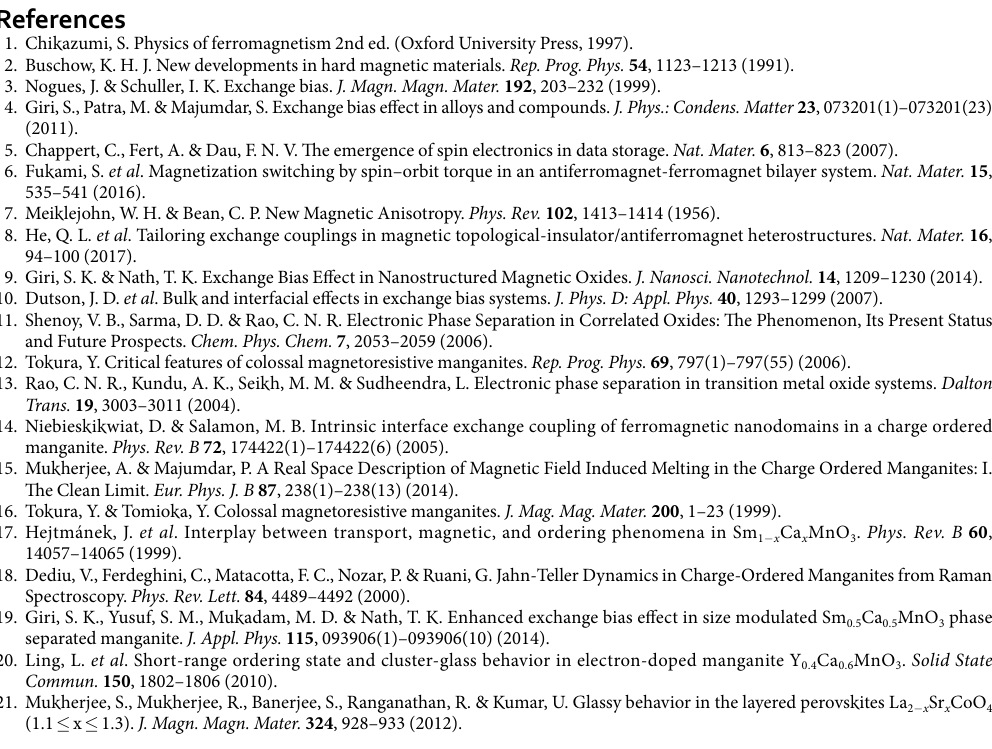
Methods Polycrystalline samples of Sm 1 − x Ca x MnO 3 (x = 0.5, 0.55, 0.6) have been prepared by well known sol-gel tech- nique. Sm 2 O 3 , CaCO 3 and MnO 2 were used as starting materials. Appropriate amount of oxides were separately dissolved in a HNO 3 solution (Oxalic acid is also added in case of MnO 2 ). These solutions were mixed, and an amount of citric acid equivalent to the total number of moles of metal ions was added under moderate heat- ing and stirring conditions. Subsequently mixture was slowly evaporated at 80–90 °C in water bath resulting in the formation of gel which was heated to 250 °C to remove the organic matter and decompose the nitrates of the gel. The black ash thus obtained was grinded and further heated to 550 °C for 5 h to kick off the remaining organic matter and then pelletized. The pellets then finally sintered for 24 hours at 1250 °C to obtain bulk samples. Nanoparticles of Sm 0.4 Ca 0.6 MnO 3 (Sm 0.4 Ca 0.6 MnO 3 -900) has been prepared by sintering the pellets at 900 °C for 3 hours. X-ray diffraction (XRD) study was carried out, with Rigaku diffractometer in Brag-Brentano geometry, using Cu-K α source having wavelength 1.54 Å . Magnetization was measured using VSM-SQUID magnetometer (Quantum Design). Some of the Magnetization measurements were carried out on a vibrating sample magneto- meter (VSM) coupled to a 9 Tesla physical property measurement system (PPMS) (Quantum Design, USA) at UGC-DAE Consortium for Scientific Research, Mumbai Centre.